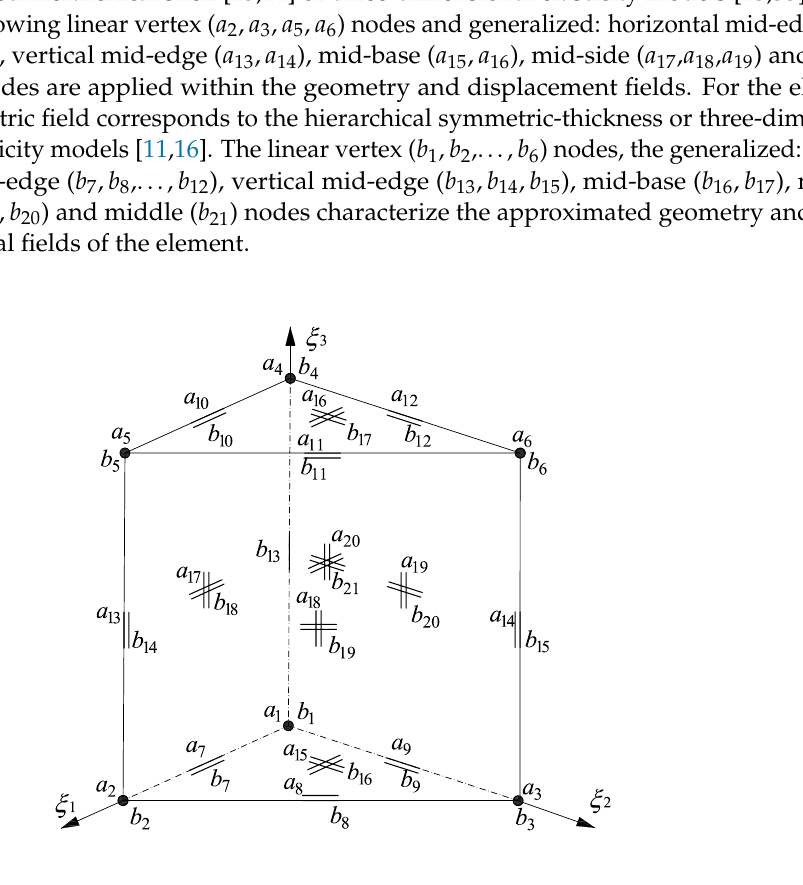
Figure 1. An exemplary principal geometry I of the transition